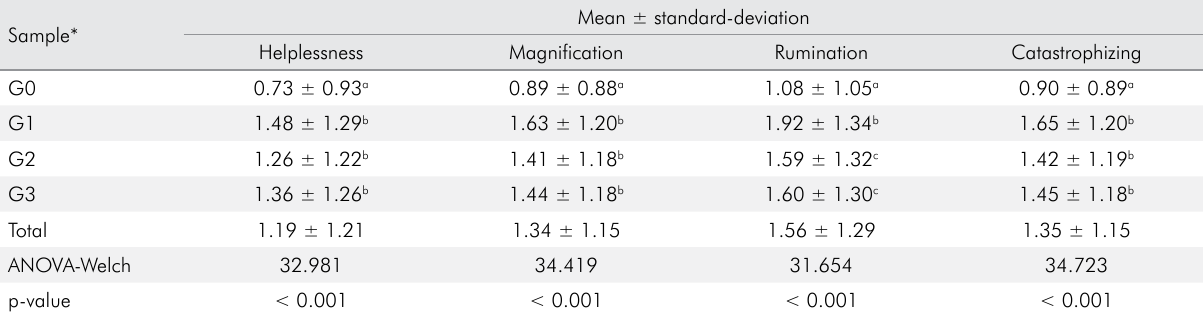
Table 6. Comparison of the mean ± standard-deviation of the scores for the Helplessness, Magnification, Rumination, and Catastrophizing factors of the Pain Catastrophizing Scale between the groups with differing pain